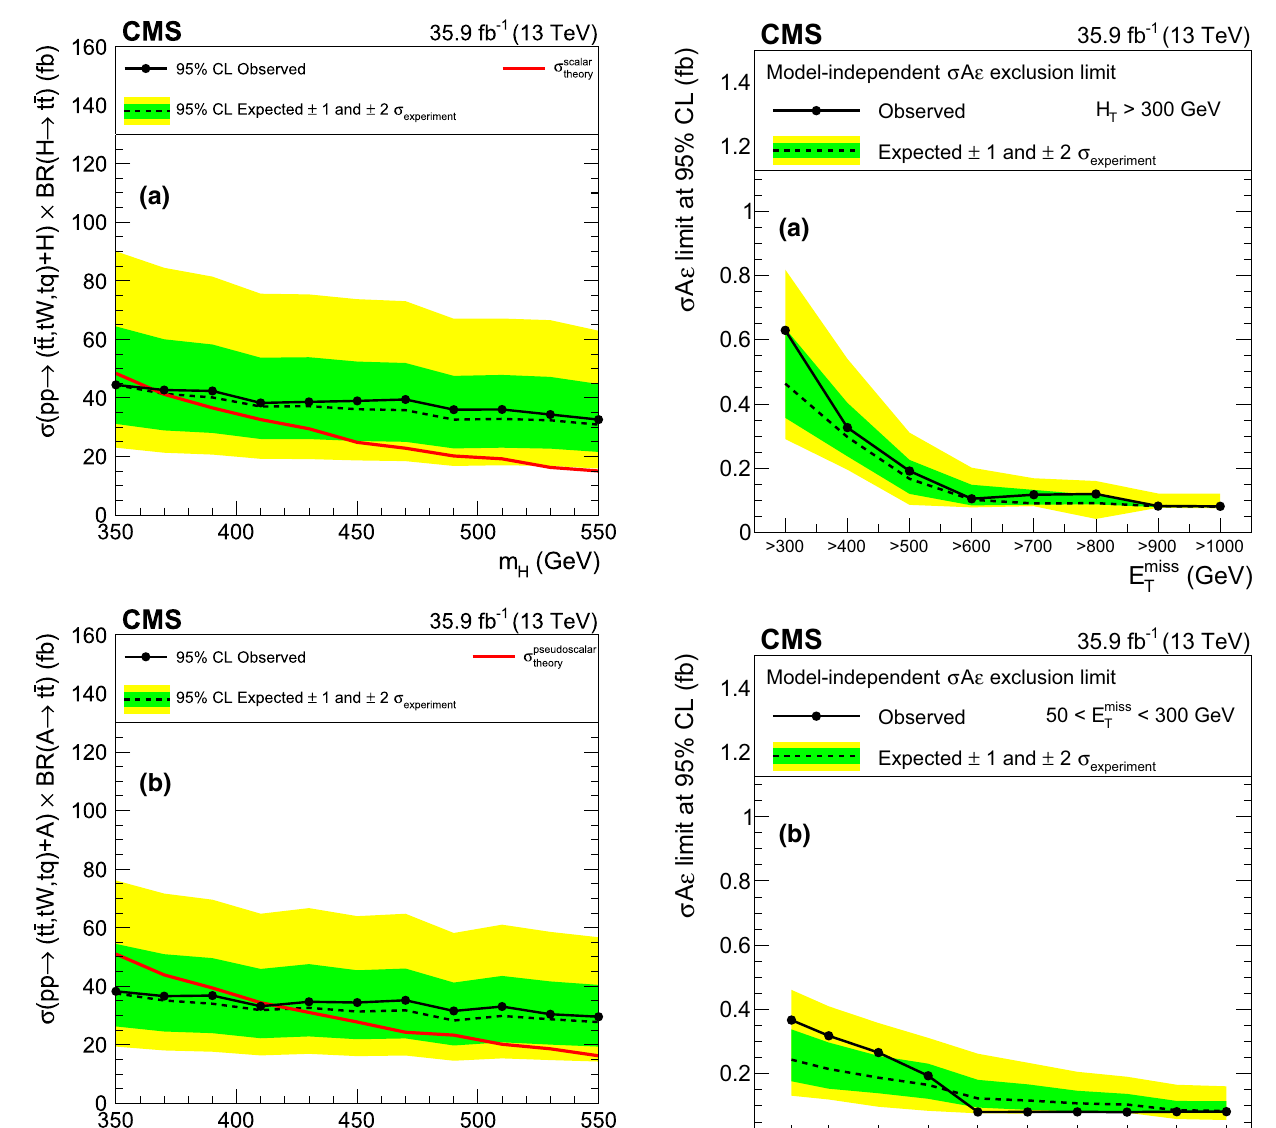
Fig. 9 in terms of σ A (cid:8) , the product of cross section, detec- tor acceptance, and selection efficiency. Where no events are observed, the observed and expected limits reach 0.1 fb,